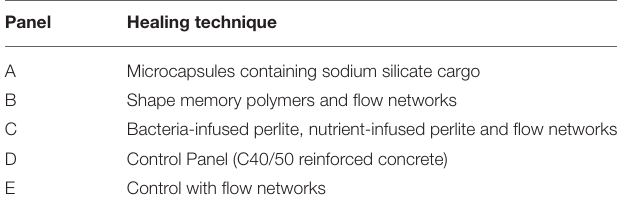
TABLE 2 | Trial panel and embedded self-healing mechanisms.